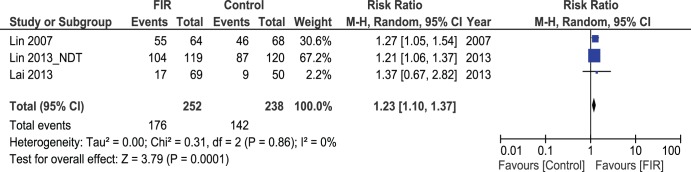
Forest Plot showing Primary AVFs patency at 12 months, Lin et al RCT on new AVFs excluded.